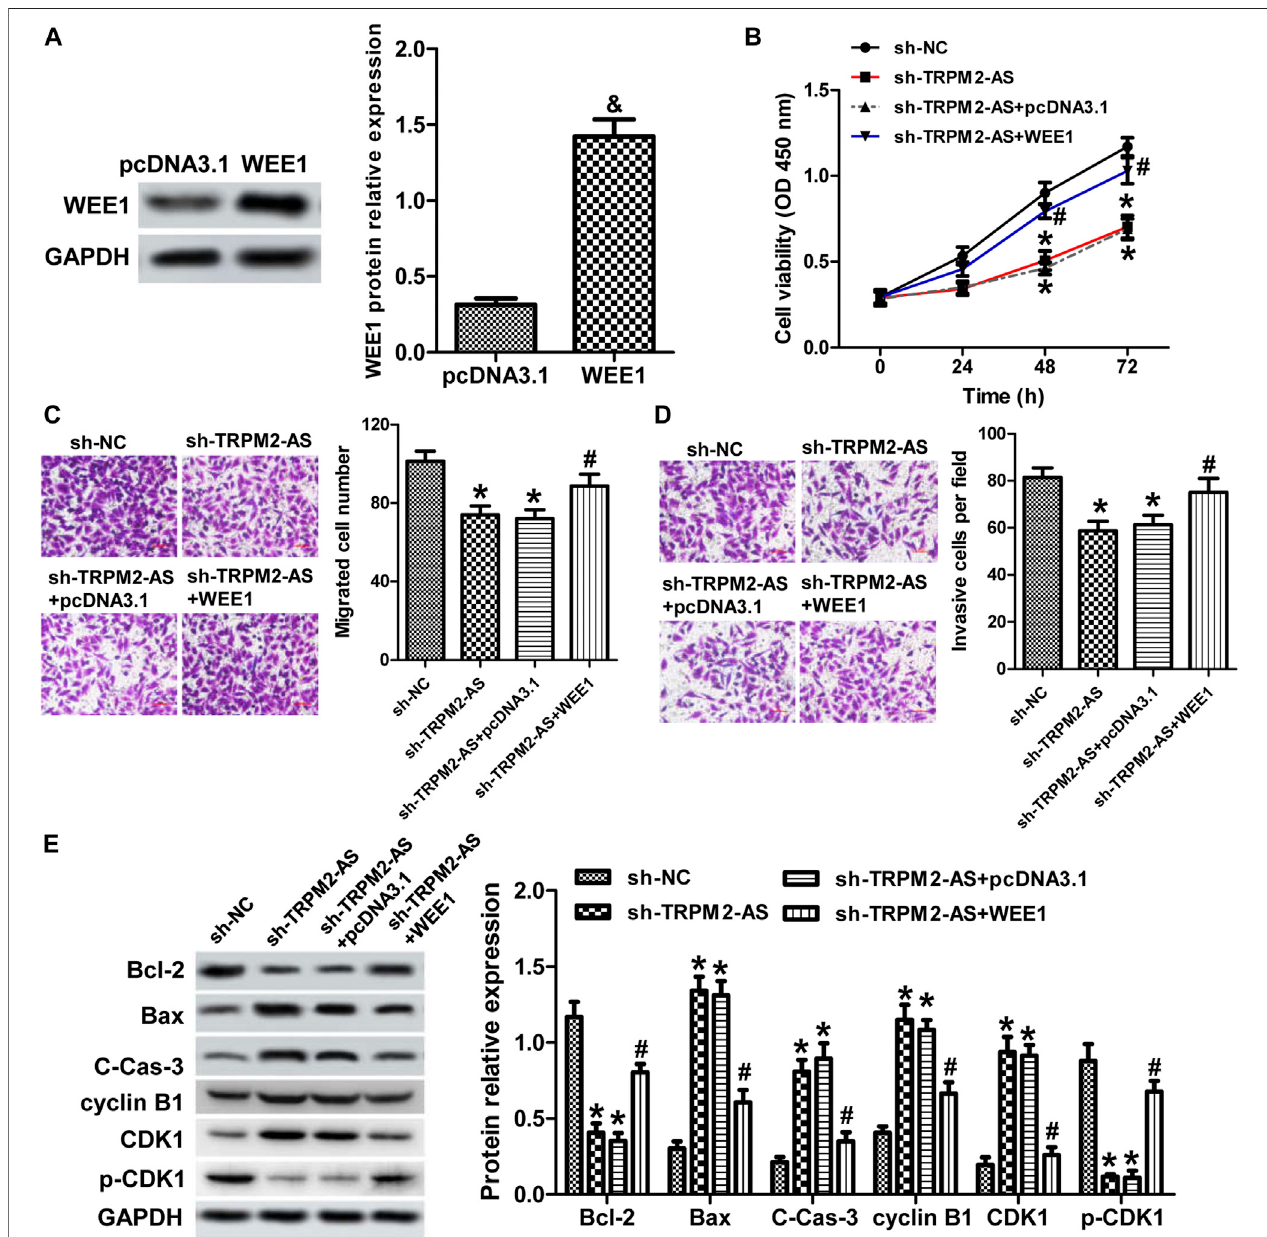
FIGURE 7 | Upregulation of WEE1 abrogated the in fl uence of TRPM2-AS knockdown on RB cells. (A) WEE1 protein levels were elevated in Weri-Rb1 cells were transfected with pcDNA3.1-WEE1 plasmid compared with its control plasmid. (B) Weri-Rb1 cells were transfected with TRPM2-AS shRNA and pcDNA3.1-WEE1 plasmid. Cell proliferation was analyzed by CCK-8 assay. The migrated (C) and invasive (D) cell numbers suppressed by TRPM2-AS shRNA were reversed by WEE1 overexpressing. ( E) Protein levels of Bcl-2, Bax, cleave-caspase-3, cyclin B1, CDK1, and p-CDK1 in Weri-Rb1 cells under different treatments. & p < 0.05 vs. the pcDNA3.1 group; * p < 0.05 vs. the sh-NC group; # p < 0.05 vs. the sh-TRPM2-AS group.